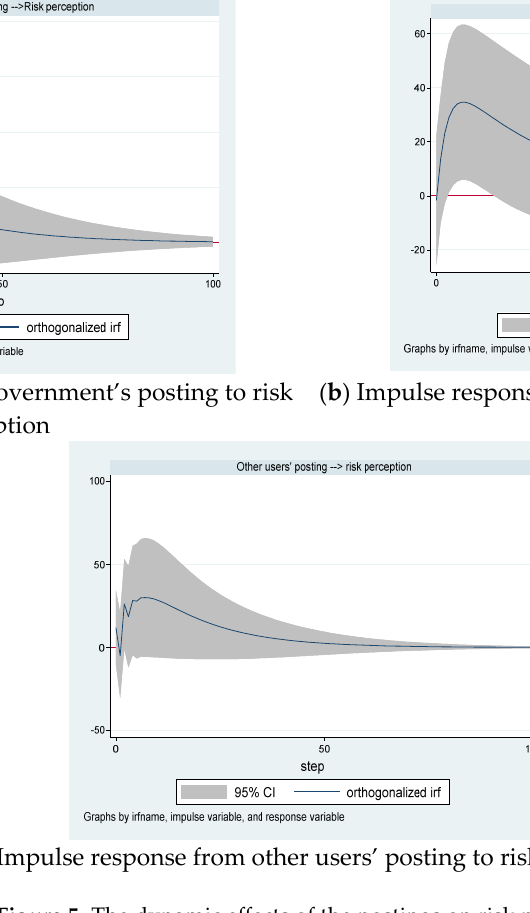
Figure 5. The dynamic effects of the postings on risk perception.